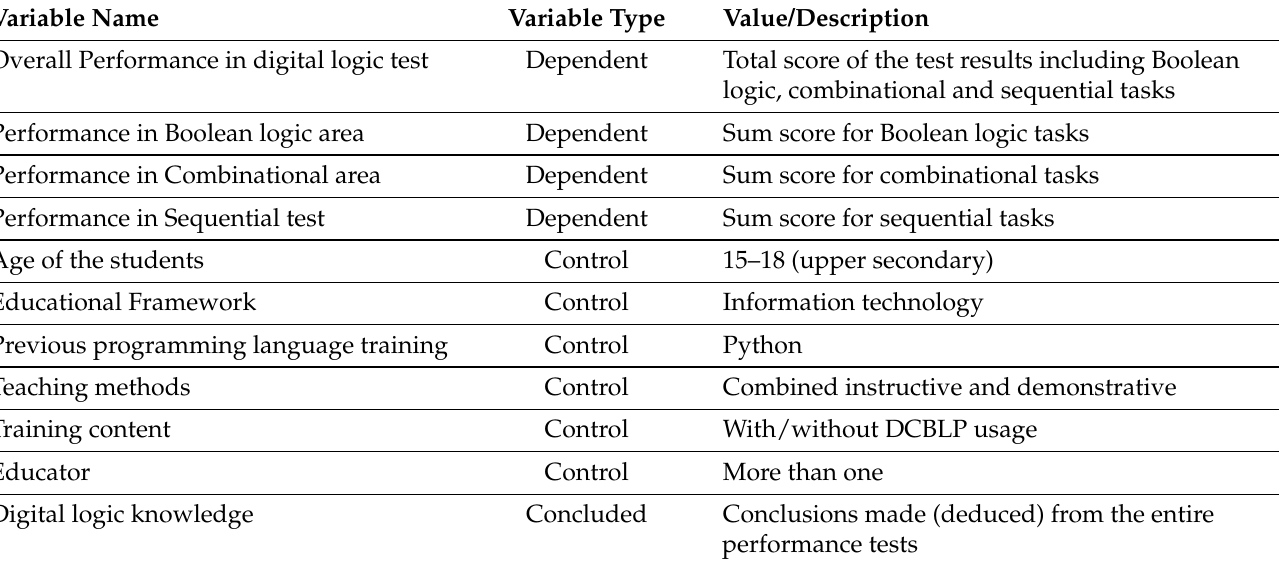
Table 2. Identified Variables for Cognitive Area.